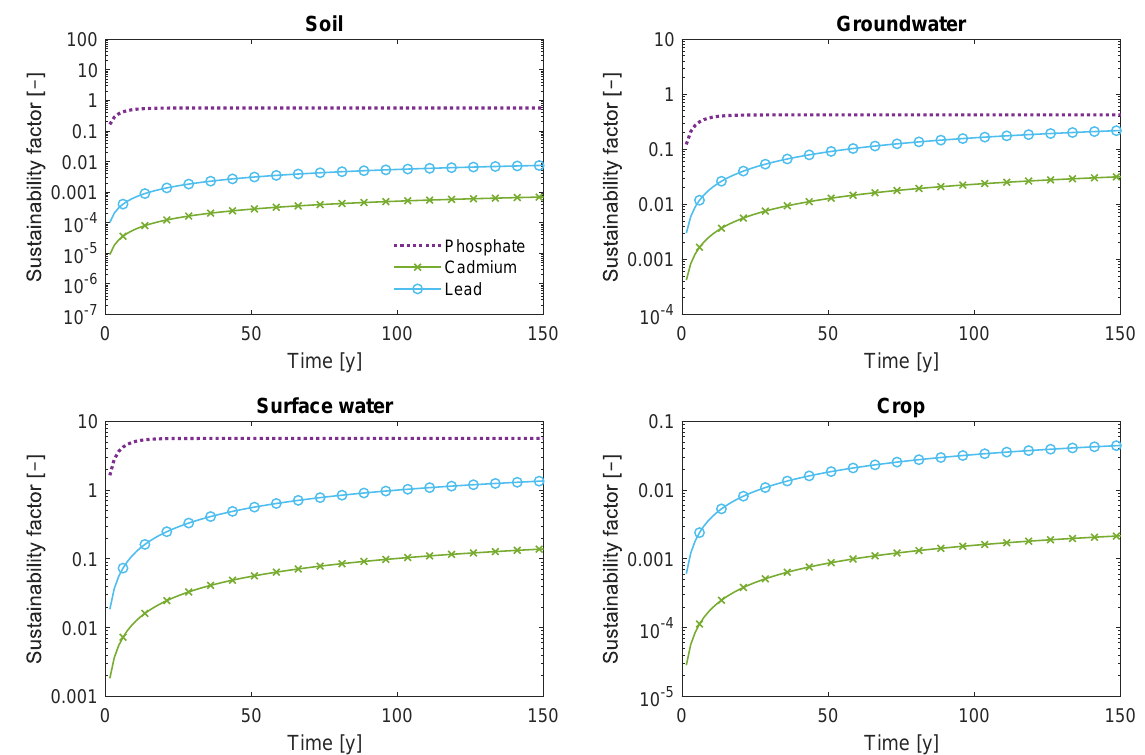
Figure 3. The long-term change of the sustainability factors over time in each environmental compartment, plotted for the persistent contaminants phosphate, cadmium, and lead. Note the logarithmic scale of the